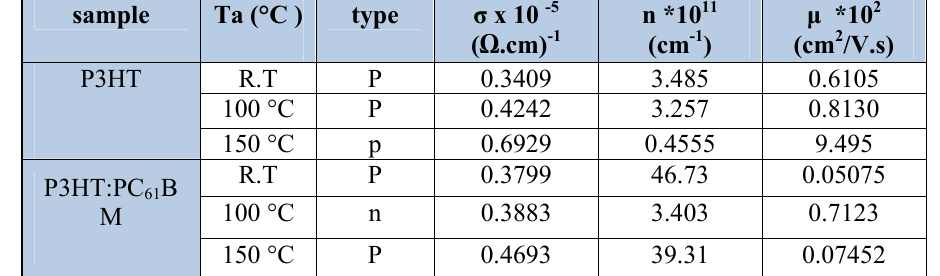
Table 4: The electrical measurements of pristine P3HT and P3HT:PC different annealing